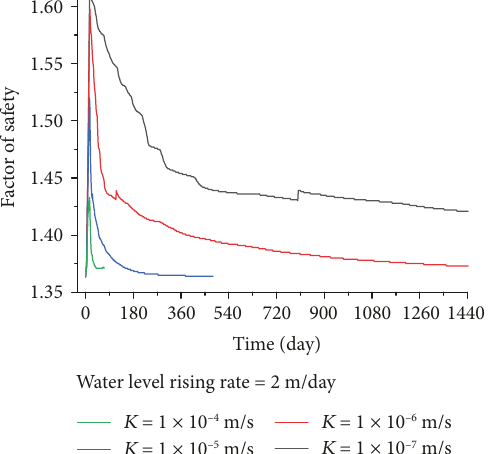
Figure 15: FOS variation under the water level rising rate of